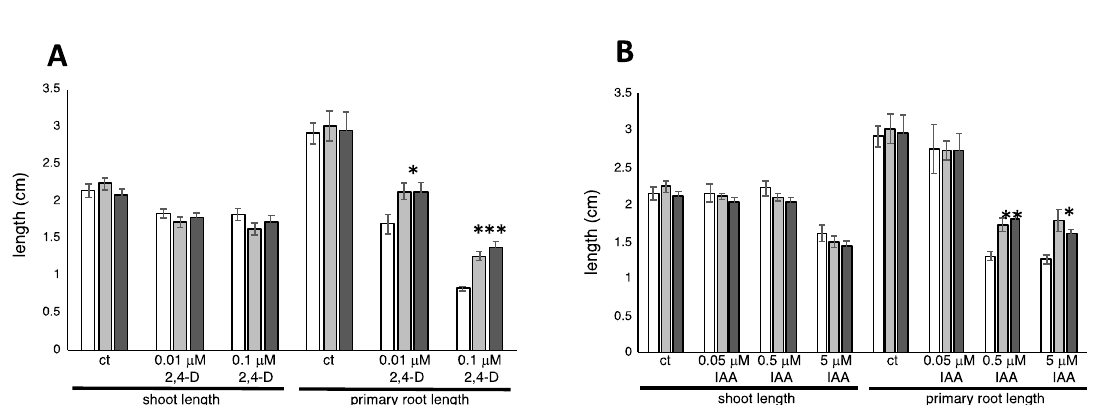
Figure 6. Phenotypic characterization of Ljafb6-1 and Ljafb6-2 mutants. Wild type and Ljafb6 plants were grown in the presence of different concentrations of 2,4-D and IAA. ( A ) Shoots and primary roots length of wild type and Ljafb6 plants, 10 days after transfer on 2,4-D media. ( B ) Shoots and primary roots length of wild type and Ljafb6 plants 10 days after transfer on IAA media. Ct indicates control plants grown without addition of hormones. Bars represent means and SE of measures from three experiments (12 plants per experiment per condition). Asterisks indicate significant differences between plant genotypes in the same conditions of growth. * p < 0.05; ** p < 0.002; *** p < 0.0001.